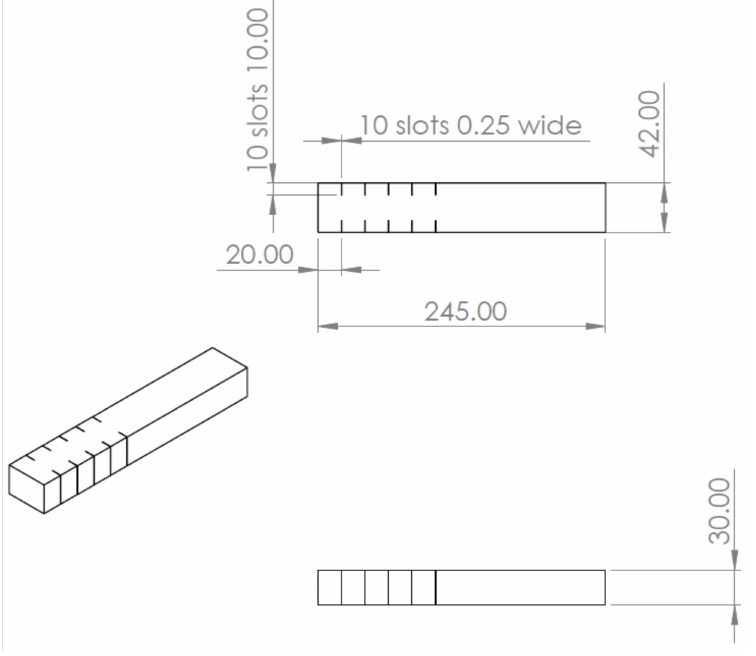
Figure 22. Drawing of the specimen with dimension for wire EDM cut. The experiment was carried out for different parameters. The details of the parameters are provided in Table 14. Table 14. Process Parameters used in the experiments.